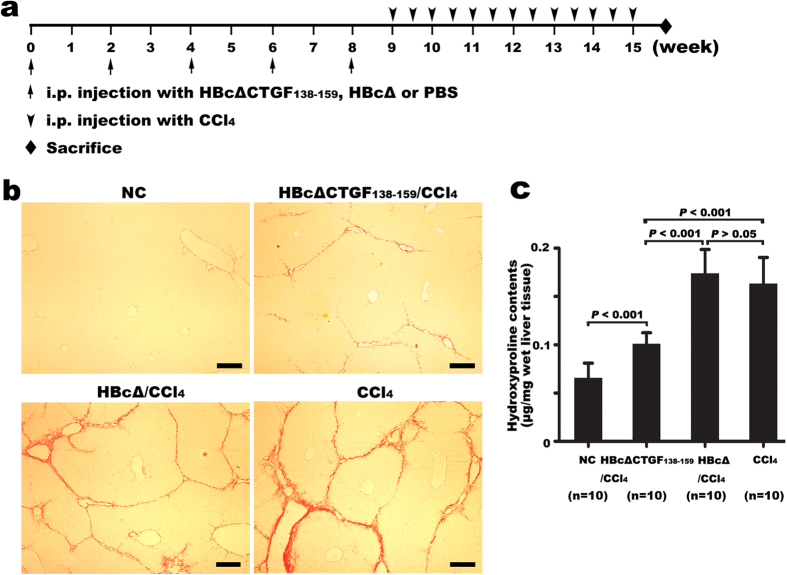
Vaccination against CTGF protected the mice from CCl4-induced hepatic fibrosis.The experimental protocol is illustrated in (a). Sirius red staining (b) and hydroxyproline content measurements (c) demonstrated that vaccination with HBcΔCTGF138–159 attenuated the hepatic fibrogenesis induced by 6 weeks of CCl4 injections. Scale bars = 200 μm. Error bars indicate SEM. CCl4, carbon tetrachloride.